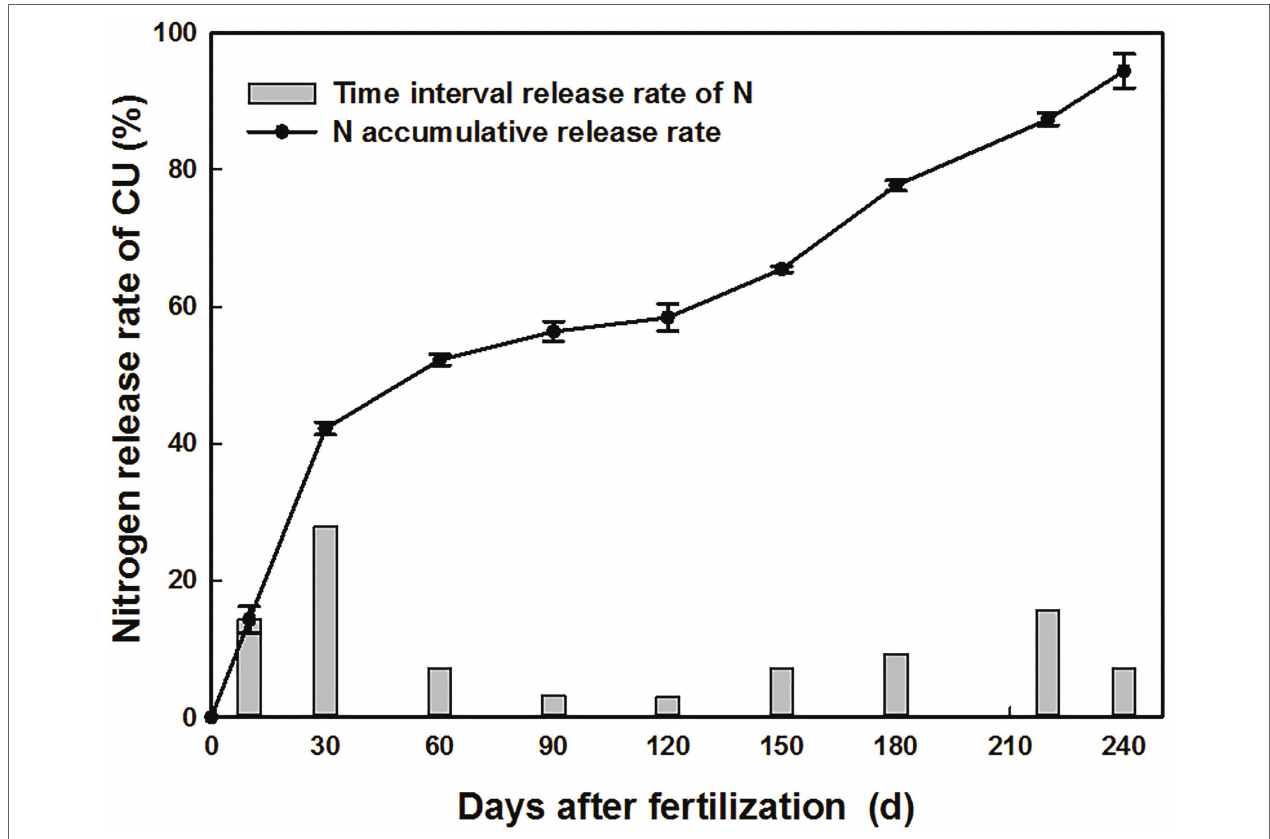
FIGURE 5 | Release characteristics of CU in soil.